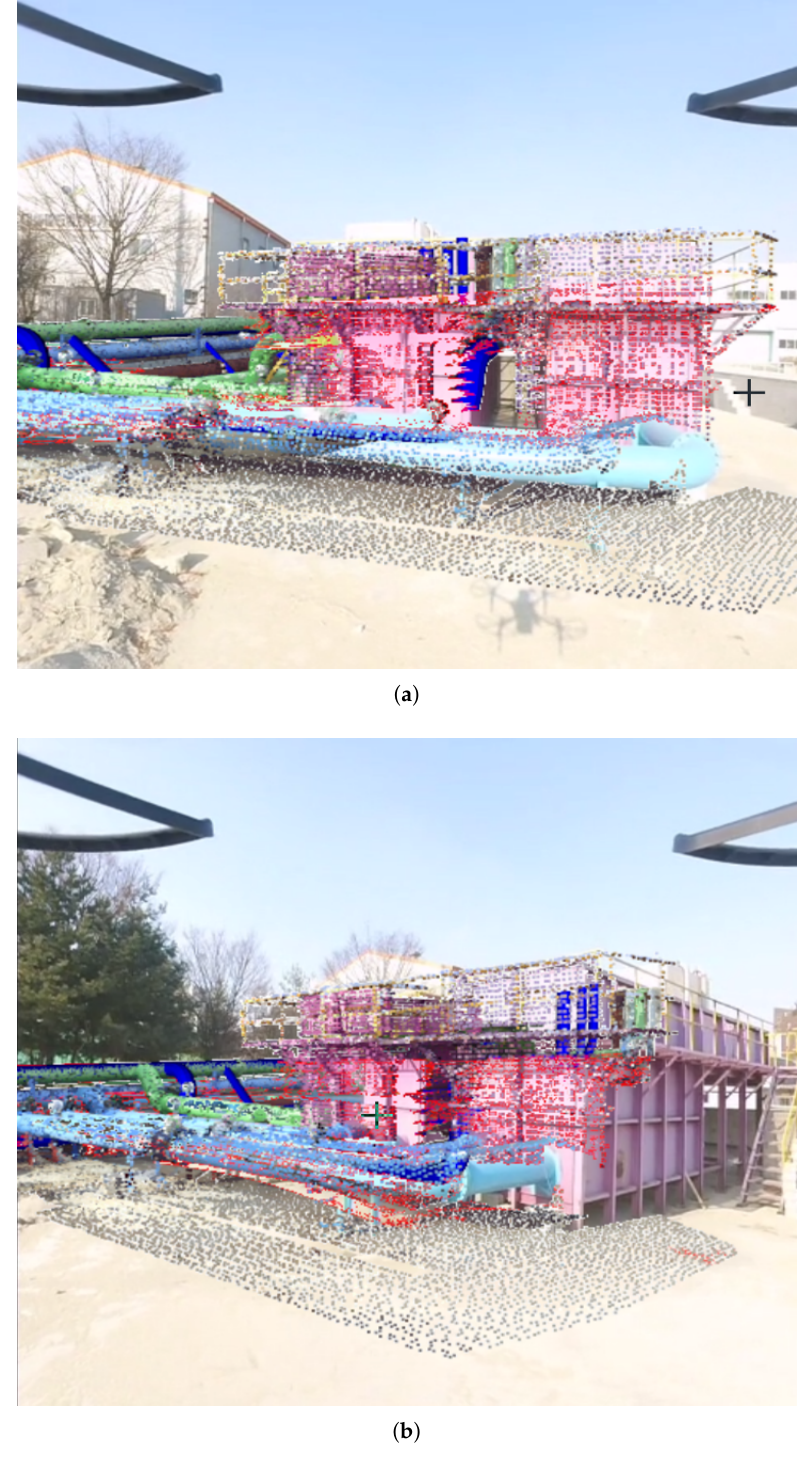
Figure 14. Pre-processed, partial PCD, CAD Model, and Video frame: ( a ) 4-in-1 alignment in first view, ( b ) 4-in-1 alignment in second